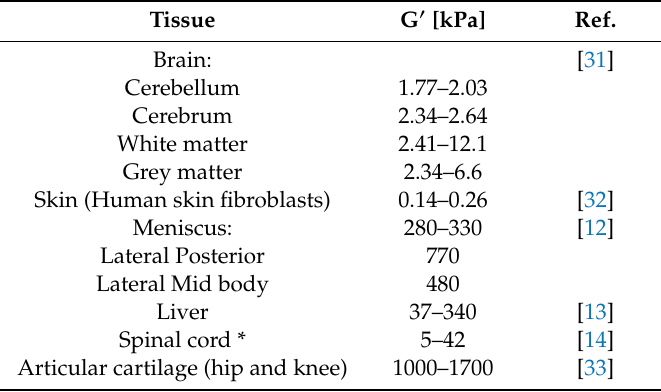
Table 2. G (cid:48) of various human tissues.